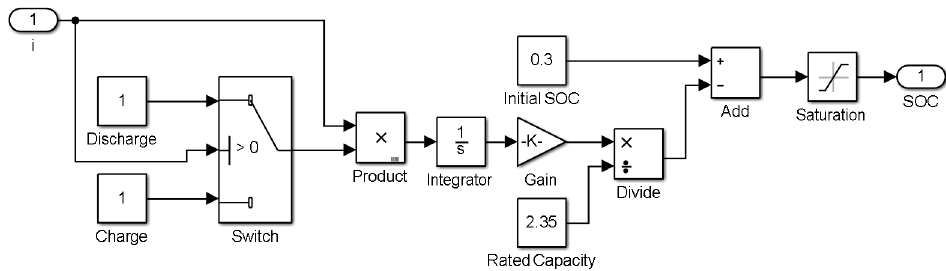
Figure 9. The simulation model of the SOC calculation for Simulink simulation.